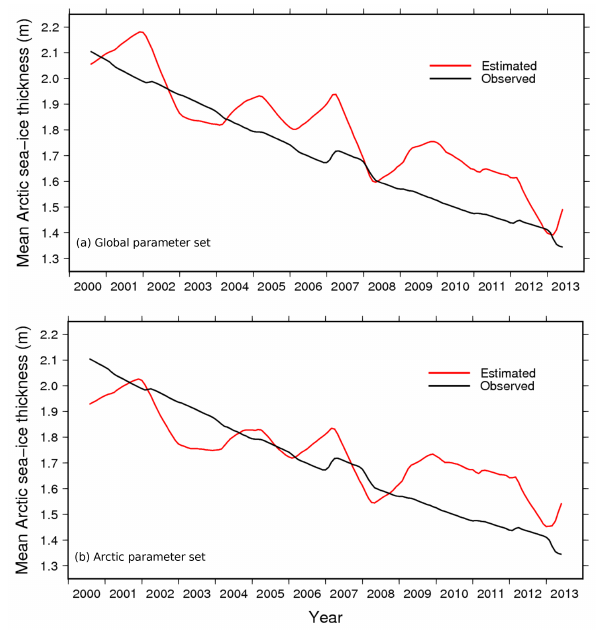
Figure 10. Observed (black, after Lindsay and Schweiger, 2015) and diagnosed (red) 12-month moving average mean sea-ice SIT of the Arctic basin (see Fig. 11) using (a) the global parameter set and (b) the Arctic-specific parameter set. Slight differences to Figure 12 of Lindsay and Schweiger (2015) appear because here we mask ice- free (SIC < 15%) areas that have a finite, non-zero ice thickness in the regression proposed by Lindsay and Schweiger (2015), who extend their regression to the entire Arctic Basin in all